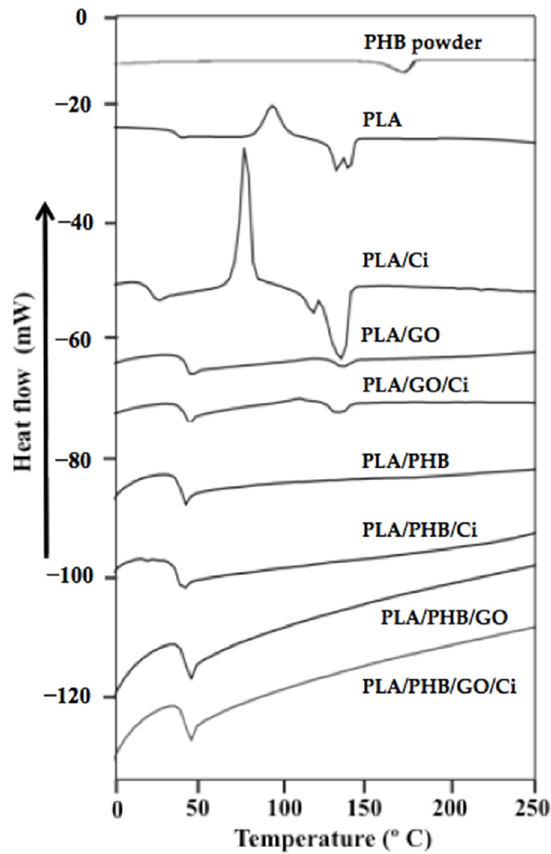
Figure 4. DSC thermograms of different materials obtained.